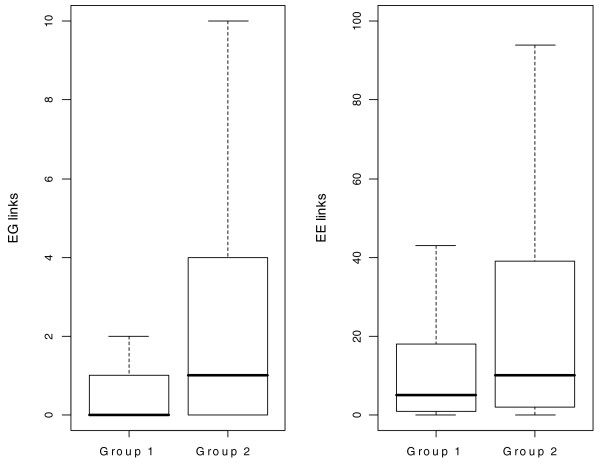
Boxplot of node degree of constitutive exons and alternative exons. Two groups of exons were assembled according to transcript annotations from 14 sources. Group 1 represents constitutive exons. Group 2 represents alternative exons. The boxplots of EG links and EE links are plotted (outliers are not drawn). Notice that alternative exons tend to have more EG and EE links than constitutive exons.